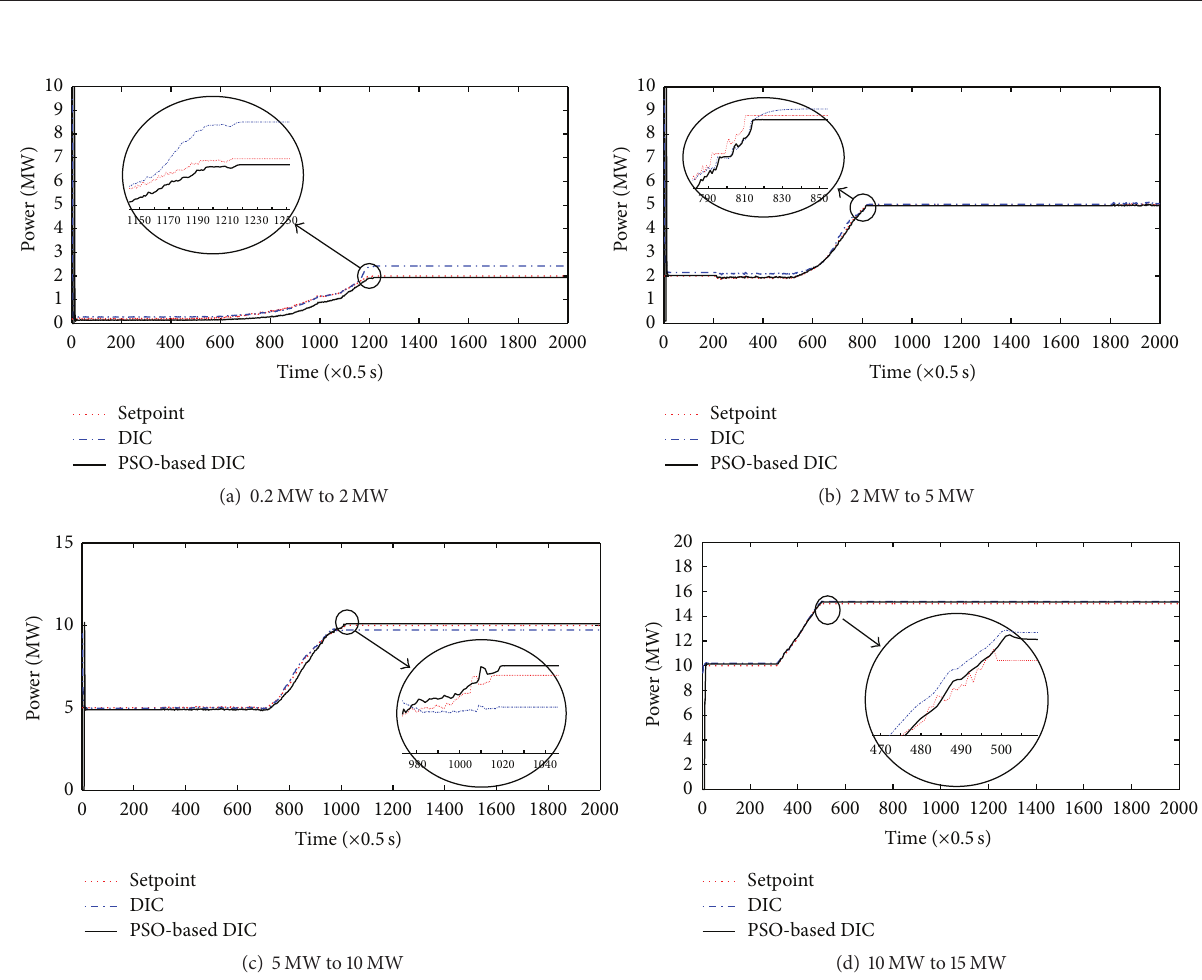
Figure 8: Comparison response of the DIC and PSO-DIC controller for specific trajectory at different power